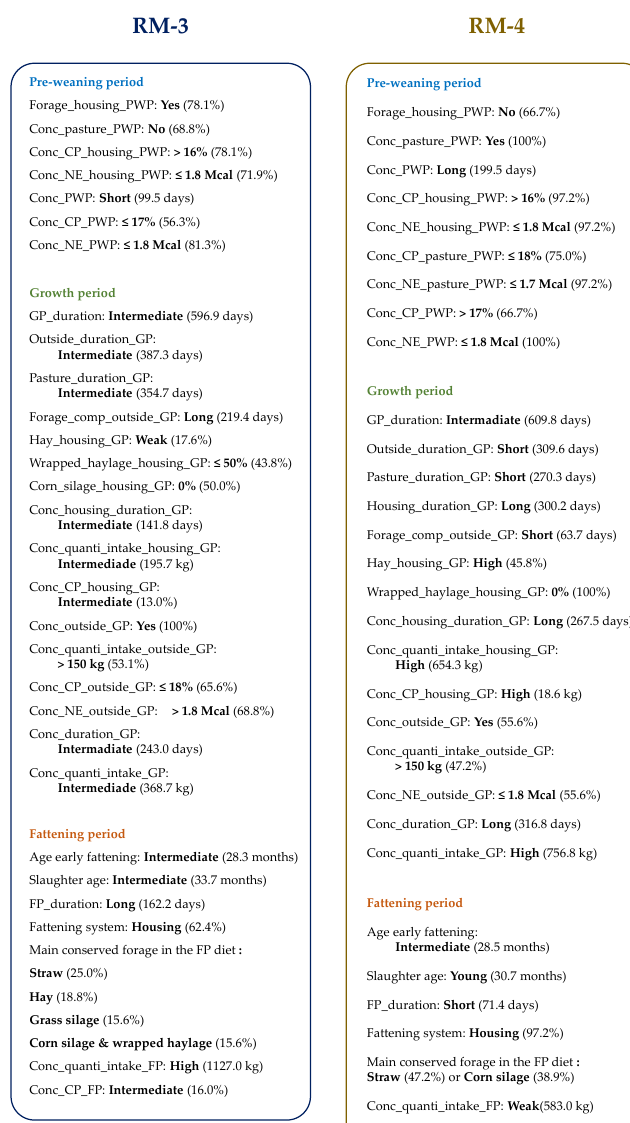
According to our results, the RM influenced carcass traits related to conformation and color (e.g., fat color, homogeneous color of the cut section, and LM color) (Table 4). In the literature, few works studied the effect of cattle’s whole life on the carcass properties.